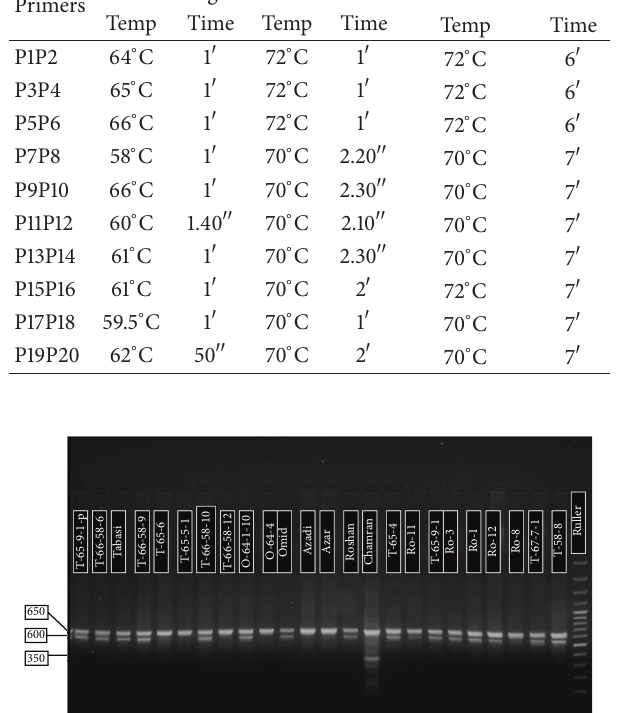
All of the genotypes except eleven (which had Dy10 allele) showed this